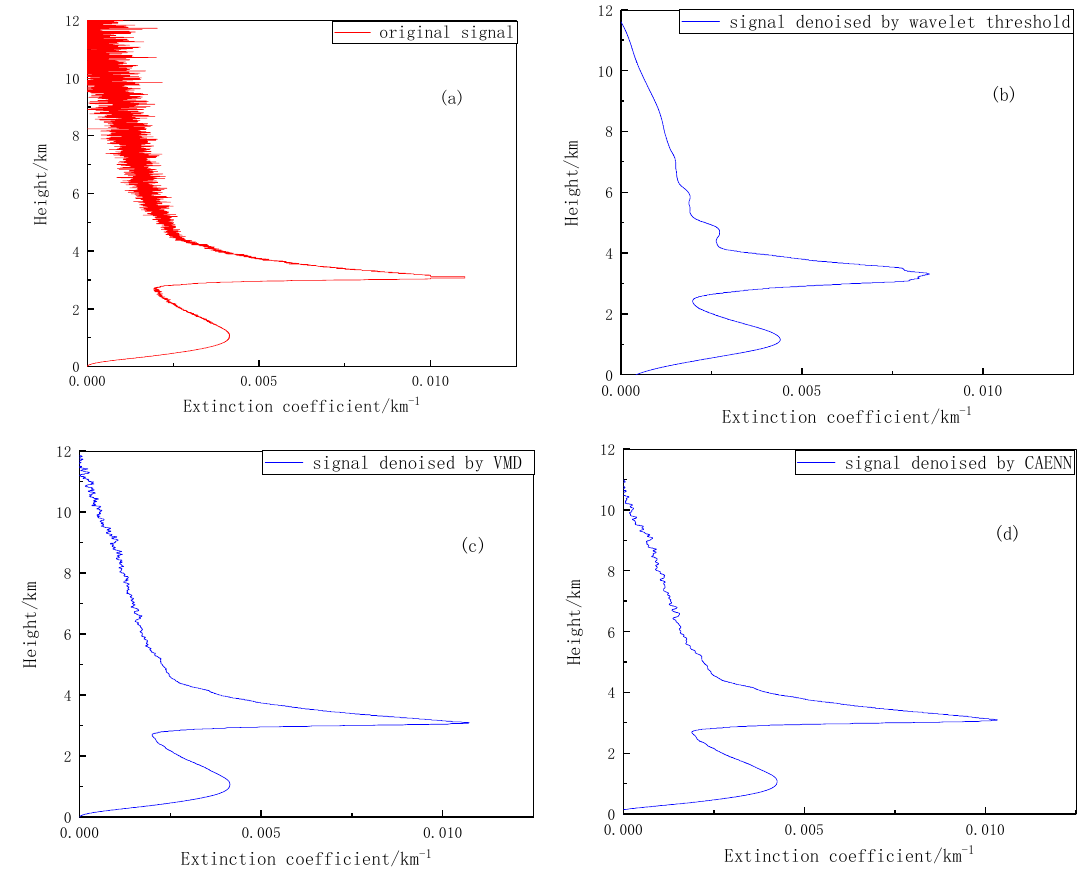
Figure 10. The aerosol extinction coefficient profiles containing a cloud layer obtained by the Klett method and its denoising effect at a wavelength of 532 nm. ( a ) the original signal, ( b ) the signal processed by the wavelet threshold method, ( c ) the signal processed by the VMD method, ( d ) the signal processed by CAENN method.